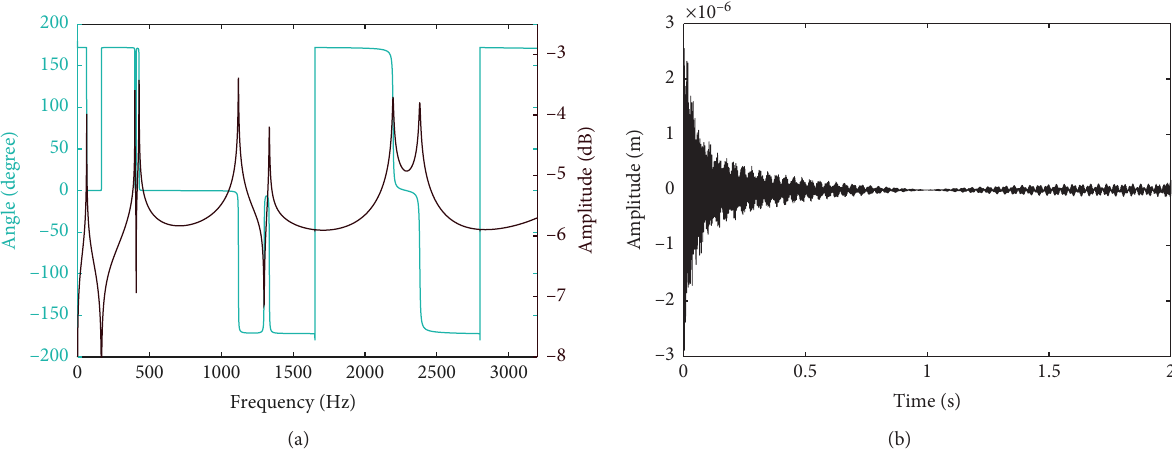
Figure 2: (a) Simulated FRF signal. (b) Simulated IRF signal.